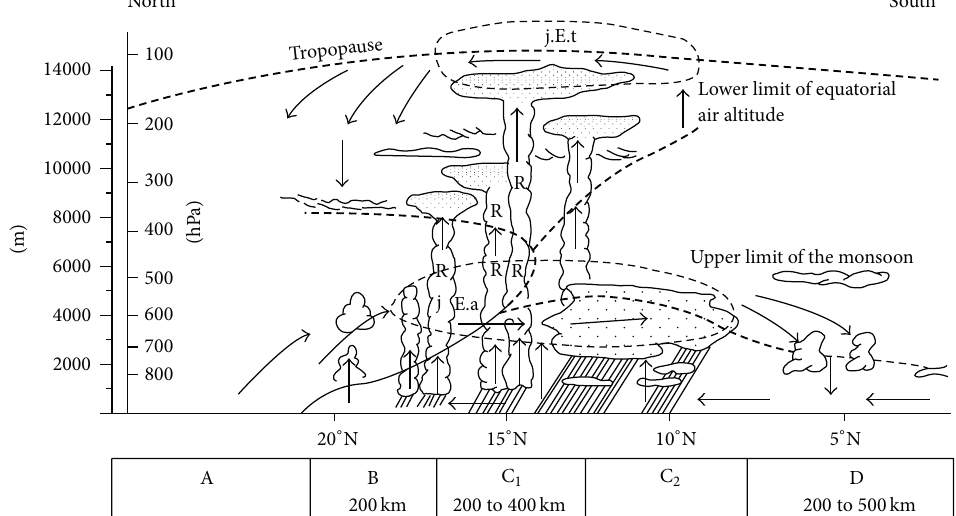
Figure 4: Diagram of the meridional structure of the atmosphere in August over West Africa (adapted to Burpee [48] and Dhonneur [49]). The arrows show flows and in particular convection or subsidence of air mass.